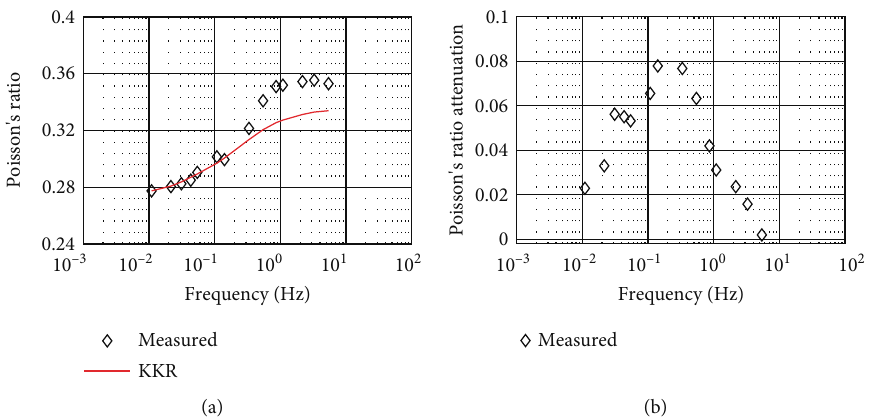
Figure 4: The frequency dependence of Poisson ’ s ratio and it associated attenuation of the glycerin-saturated Lavoux limestone sample (from Borgomano et al. [15]).